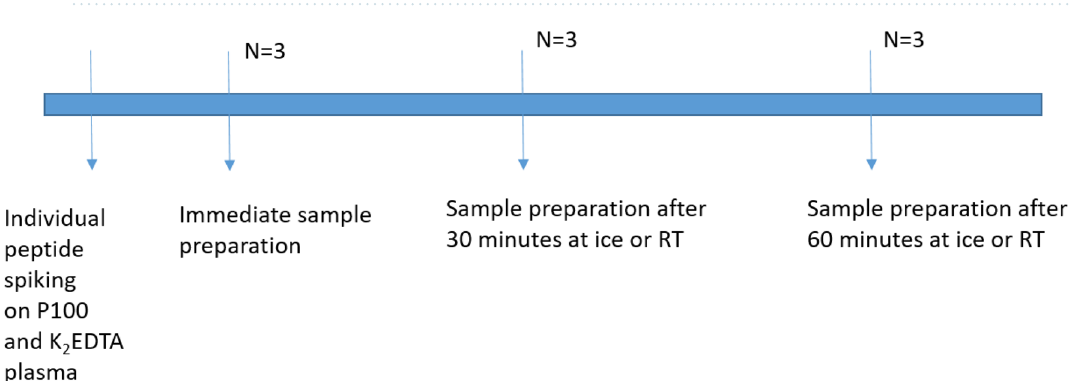
Figure 5. Stability of synthetic peptides under different storage conditions. Apelin-36 exhibits limited degradation after one hour at room temperature in plasma collected in K 2 EDTA tubes and stored non-acidified or stored acidified to pH 4.5 and pH 2.5. Limited degradation is also observed in plasma collected in a P100 tube and stored acidified to pH 2.5. In P100 plasma stored non-acidified and at pH4.5, a higher degradation is observed. P values after Kruskal–Wallis test for the difference between last and first time point: apelin-36: P = 0.0117; apelin-31: P = 0.0841; apelin-28: P = 0.0168; apelin-17: P = 0.0207; apelin-13: P = 0.0318; apelin- pyr-13: P = 0.0079; apelin-12: P = 0.0099. RT room temperature.